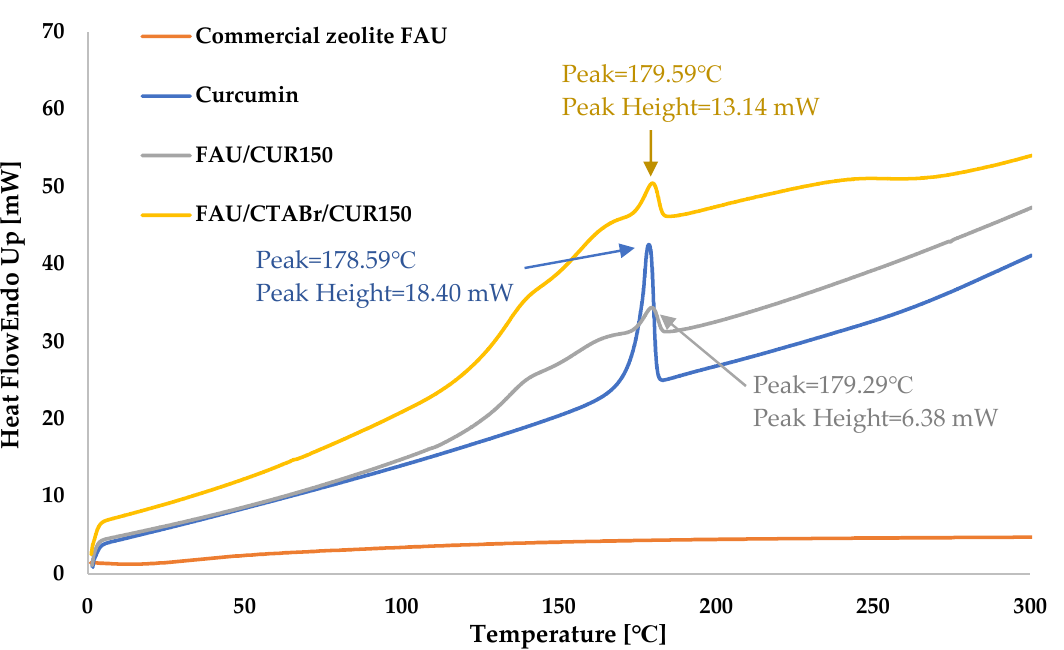
Figure 3. Recorded DSC thermograms for the tested materials in the temperature range from 0 °C to 300 °C.